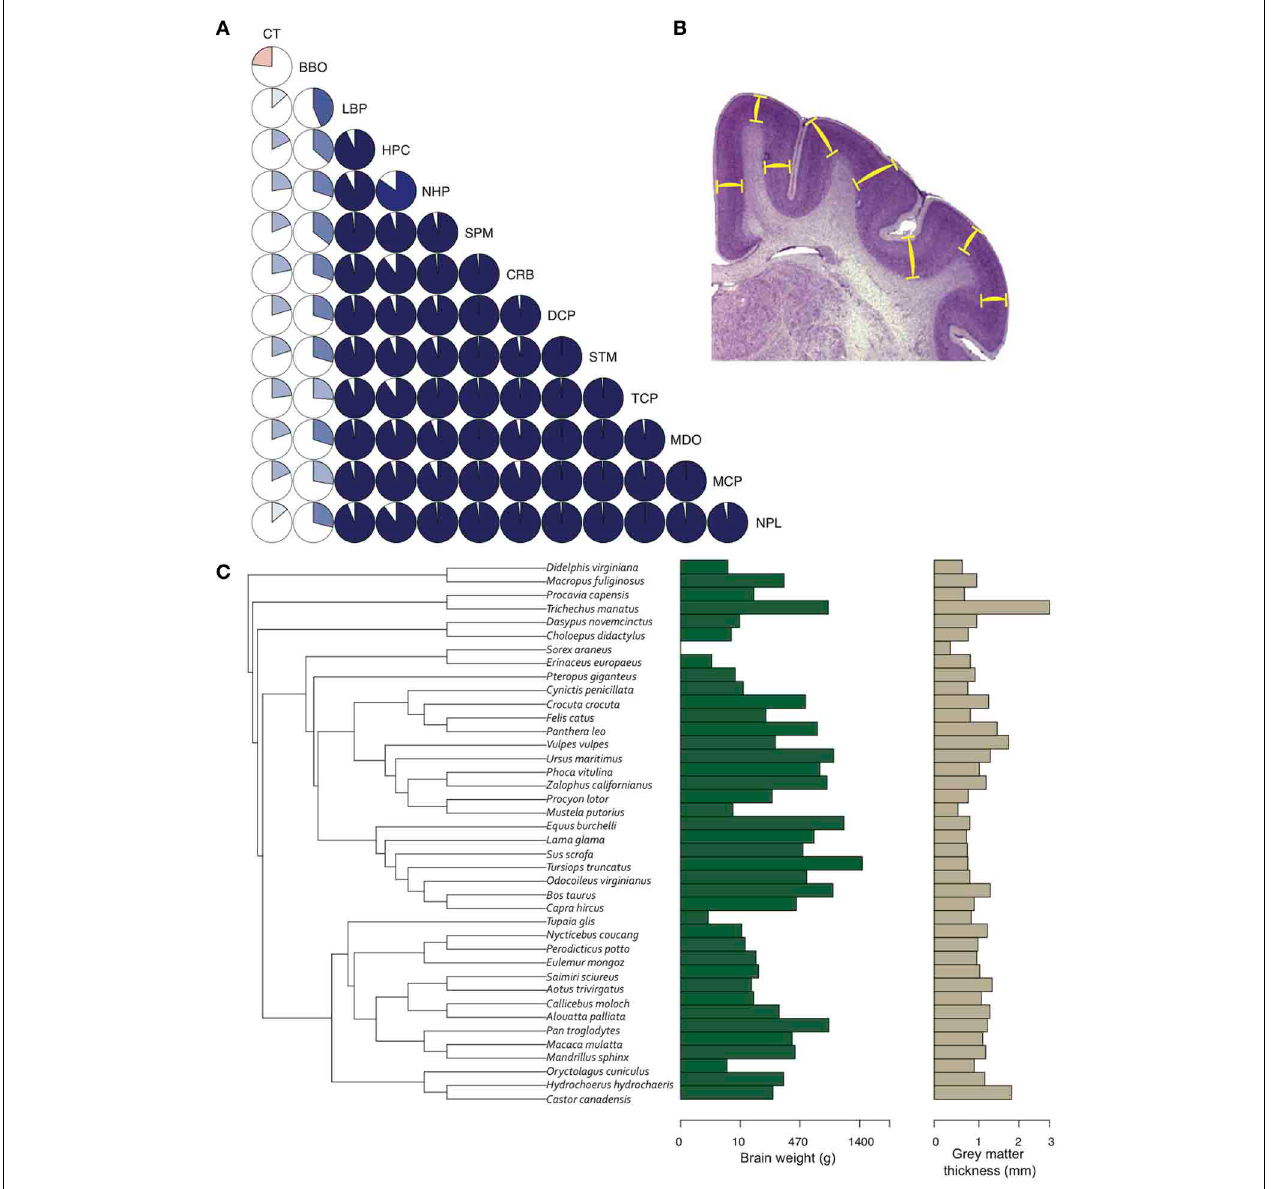
FIGURE 5 | Gray matter cortical thickness varies with brain regions and phylogeny. (A) Twelve brain region volumes and GM thickness presented in a pie-chart matrix of positive (blue gradient) and negative (red gradient) correlations. Note that all brain region volumes - except BBO, which is a developmentally and functionally separate region - show very high ( R 2 > 0 . 8) positive correlations, whereas cortical thickness is lowly ( R 2 < 0 . 4) correlated with all brain region volumes. BBO, olfactory bulb; CRB, cerebellum; CT, cortical thickness; DCP, diencephalon; HPC, hippocampus; LBP, piriform lobe; MCP, mesencephalon; MDO, medulla oblongata; NHP, neurohypophysis;